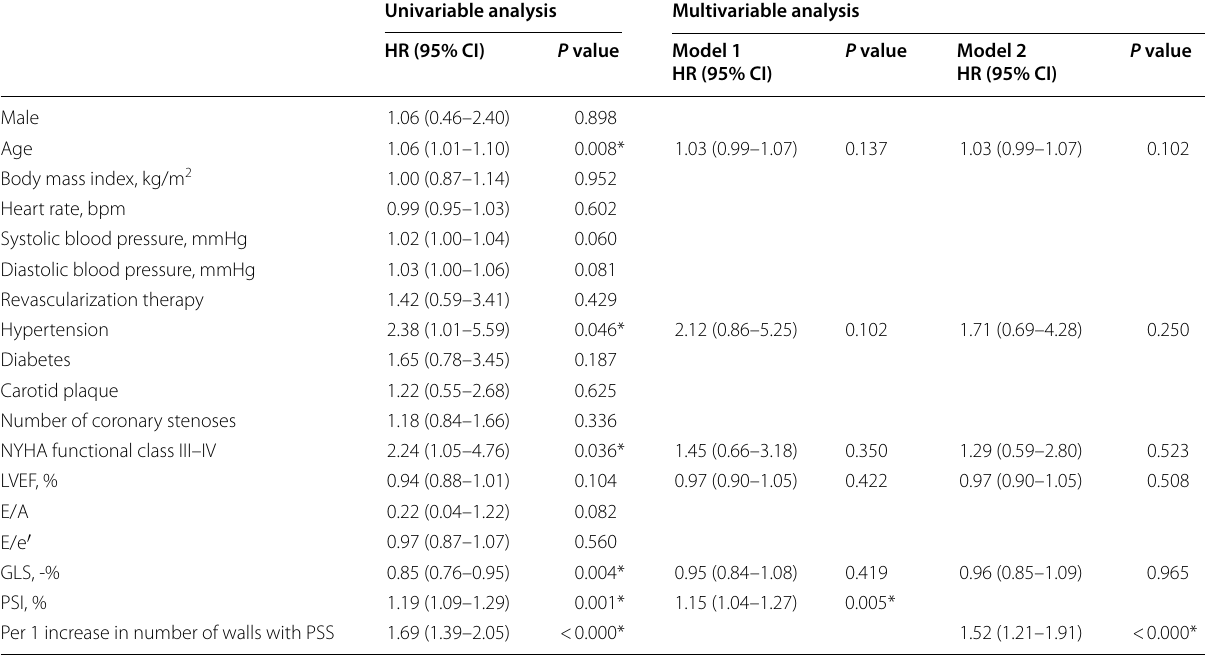
Table 4 Cox regression analysis of multiple variables on the composite endpoint